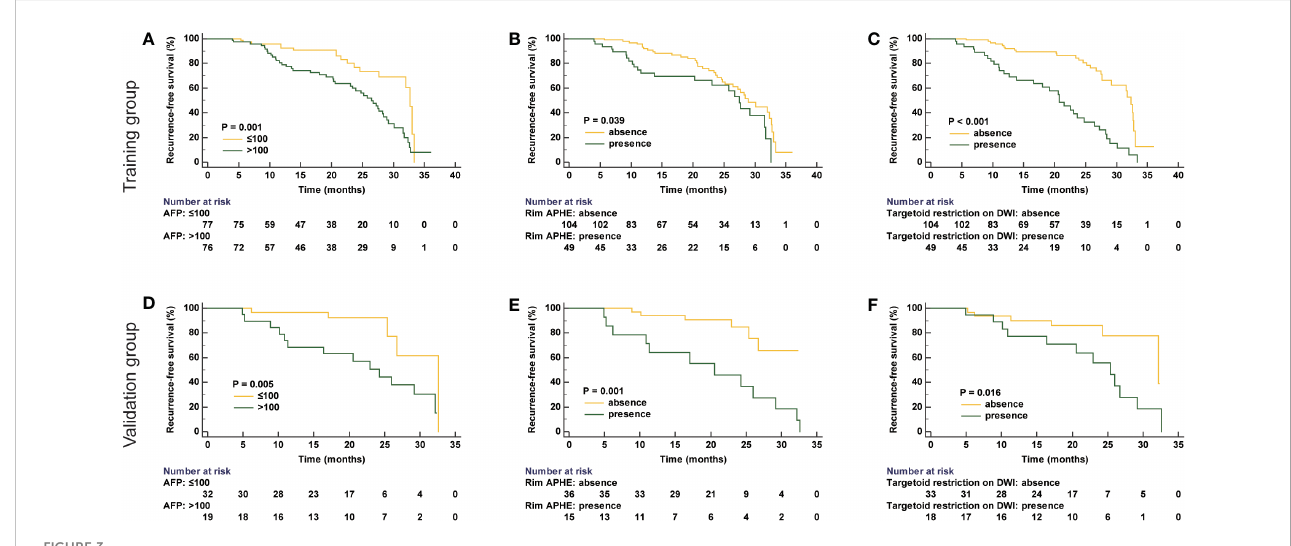
FIGURE 3 The RFS of each group in both training (A – C) and validation groups (D – F)